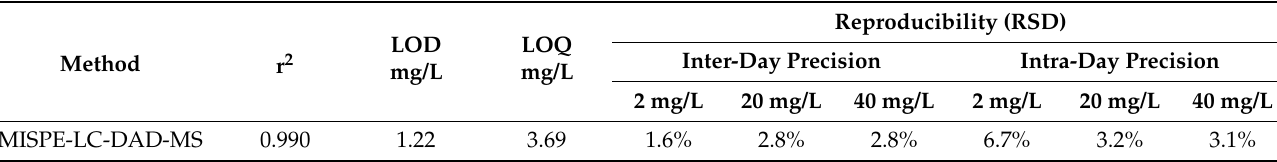
Table 2. Validation parameter of the MISPE